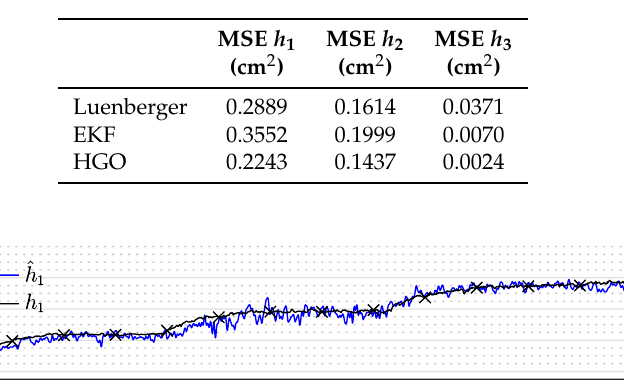
Table 3. Mean squared error (MSE) comparison.